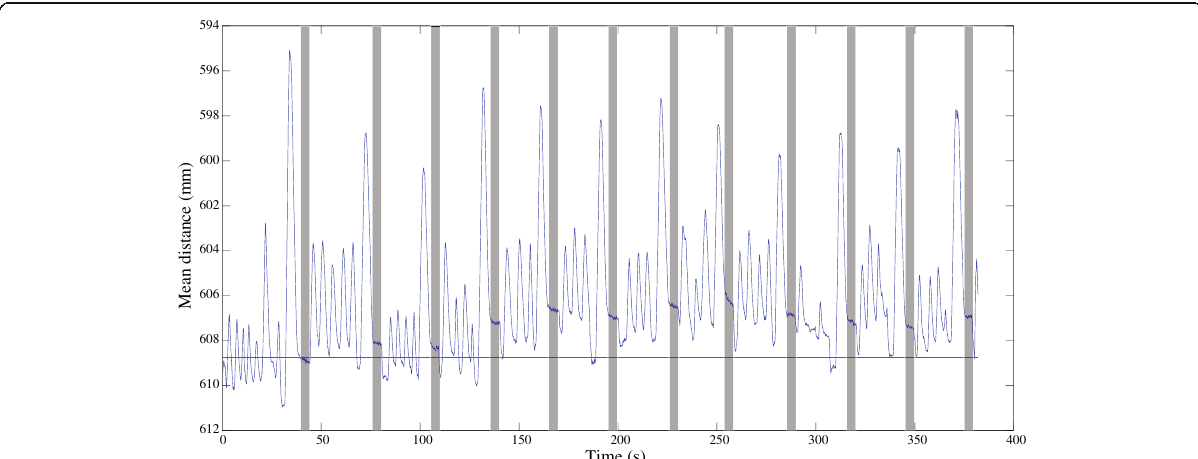
Fig. 7 Respiratory level without feedback. Respiratory level of a volunteer (F4) in the prone position, without visual feedback. Red line represents the initial level of breath-hold. The volunteer was given breathing instruction every 30 s and asked to return to the same respiratory level and maintain breath-hold for a couple of s, indicated by the short horizontal